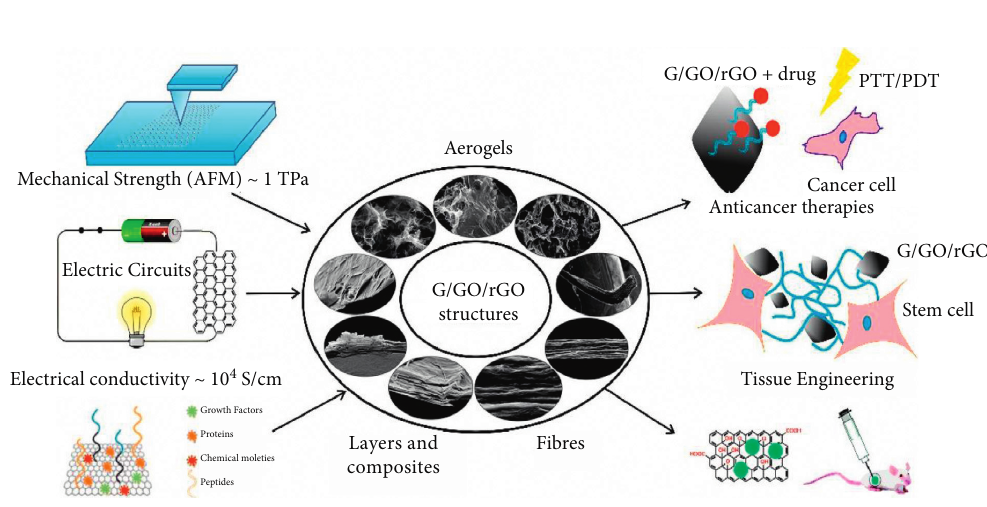
Figure 4: Multifunctional applications of graphene/graphene structure